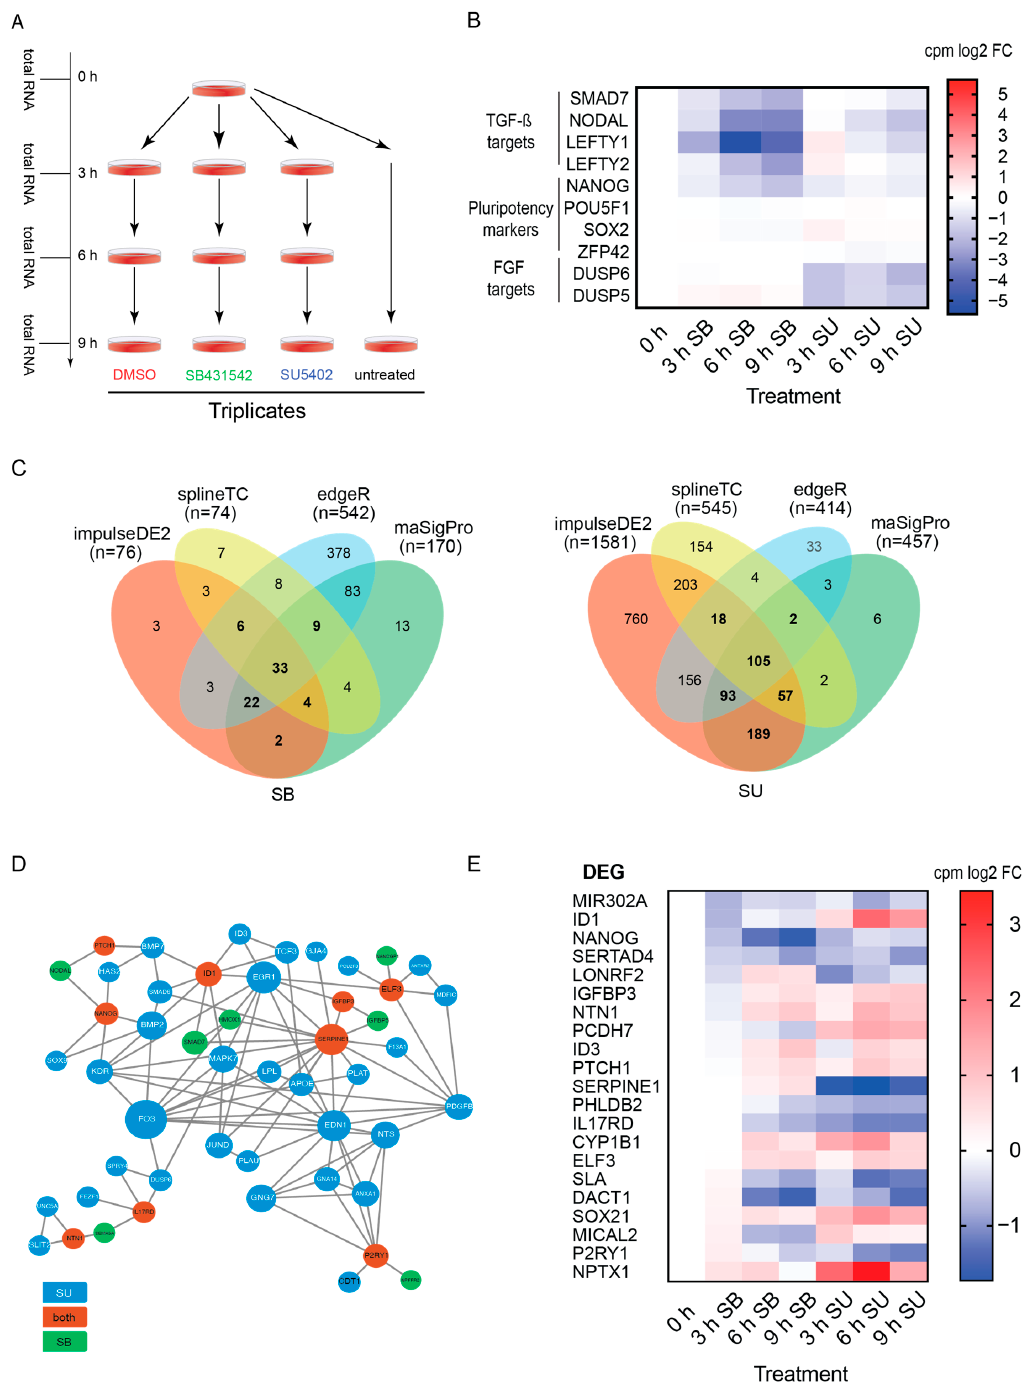
Figure 1. Time course analysis of transcriptional changes upon inhibition of TGF- β and FGF signaling pathways. ( A ) Experimental design of time course RNA-sequencing. ( B ) Heatmap of log2 fold change (compared to DMSO) counts per million expression of know TGF- β and FGF signaling targets compared to pluripotency markers. ( C ) Adjusted Venn diagram for 0.5 and 0.7 LFC filtered candidates of SB and SU, respectively, showing an overall decreased number of tool specific candidates. ( D ) Crosstalk network was generated by merging SB (green) and SU (blue) networks (Figure S1) and filtering for nodes directly connected to candidates identified in both experiments (red). ( E ) Heatmap of log2 fold change (compared to DMSO) counts per million expression of target genes common to the FGF and TGF- β pathways (sorted for maximal downregulation at 3 h of TGF- β